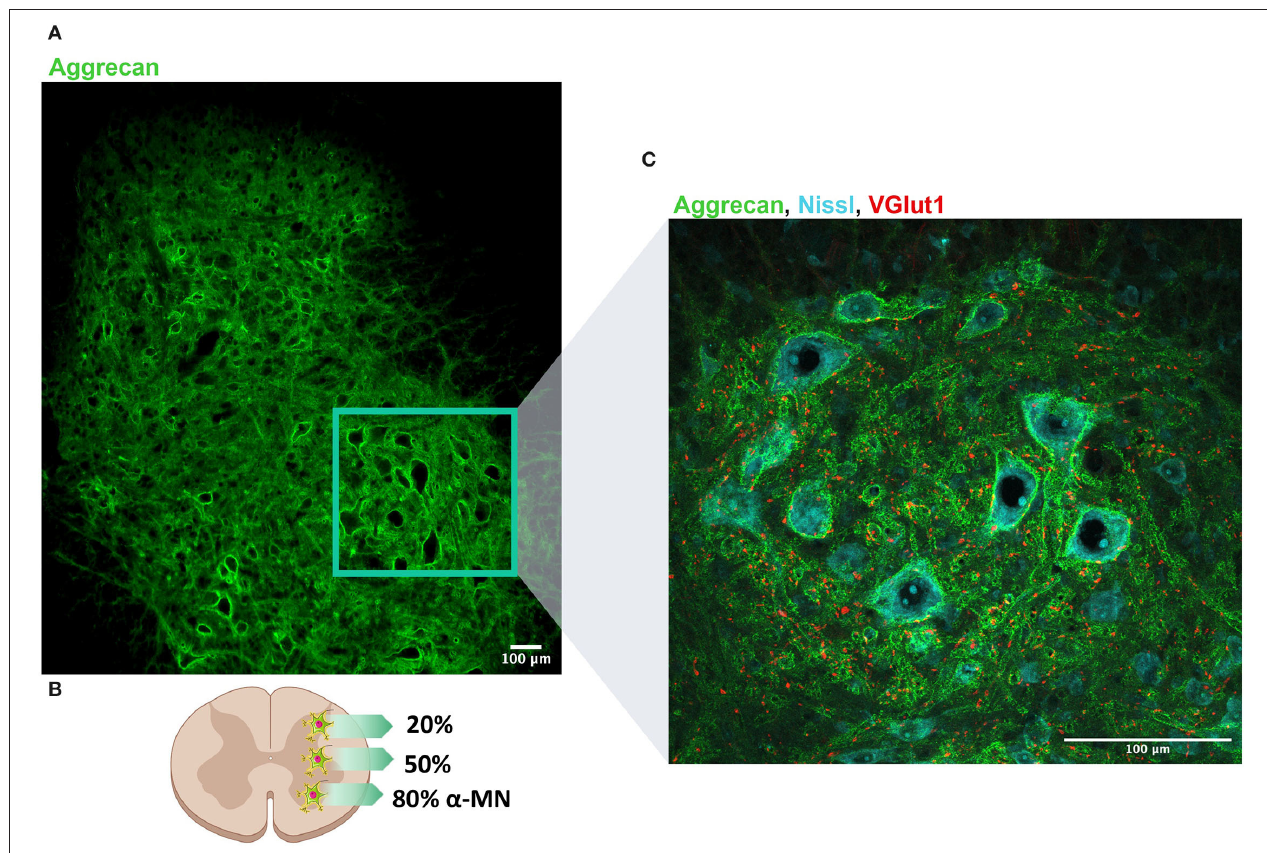
FIGURE 1 | Perineuronal nets (PNNs) distribution along the dorso-ventral axis of the lumbar spinal cord. (A) PNNs are labeled by aggrecan (denoted in green) and observed along the whole lumbar spinal cord. (B) Schematic representation of the distribution of PNNs in the spinal cord: 20% of neurons in the dorsal horn present PNNs, whereas 50% of neurons located in the intermediate column are wrapped by PNNs. Considering α -MN, around 80% are surrounded by PNN. (C) Magnification of the region of the ventral horn where most of MNs are localized. Neurons are labeled in blue (Nissl) and proprioceptive afferents (VGlut1) that typically project to MN are labeled in red. Scale bar: 100